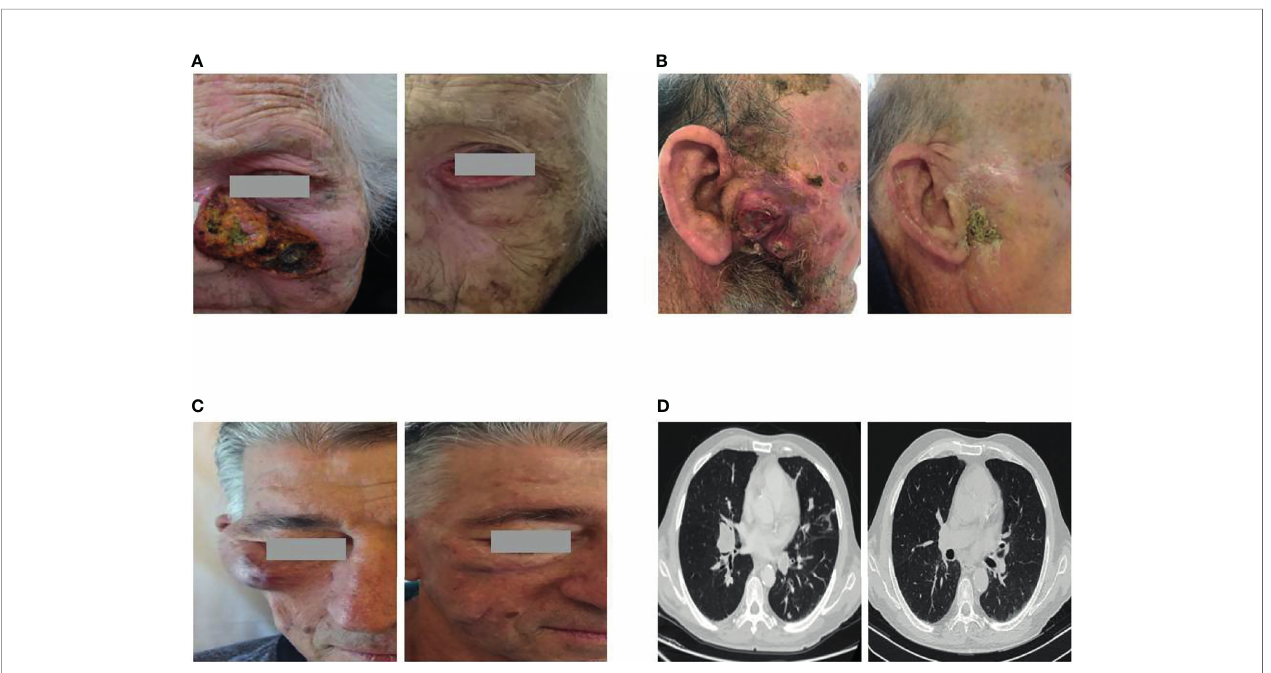
FIGURE 1 | Representative cases of patients obtaining a major response to cemiplimab. (A) An 88-year-old female with a large locally advanced cutaneous squamous cell carcinoma (laCSCC) of the left nasal-infraorbital region achieving a complete response. Neither had she received prior radiotherapy nor anticancer systemic therapy. (B) An 89-year-old man with a large laCSCC tumor of the right parotid region obtaining a complete response after 6 cycles of cemiplimab and concurrent radiotherapy. (C, D) A 67-year-old man with metastatic cutaneous squamous cell carcinoma in immunosuppressive therapy due to a previous kidney transplantation. The patient achieved a near-complete response both at the right zygomatic area and the metastatic lung lesions.